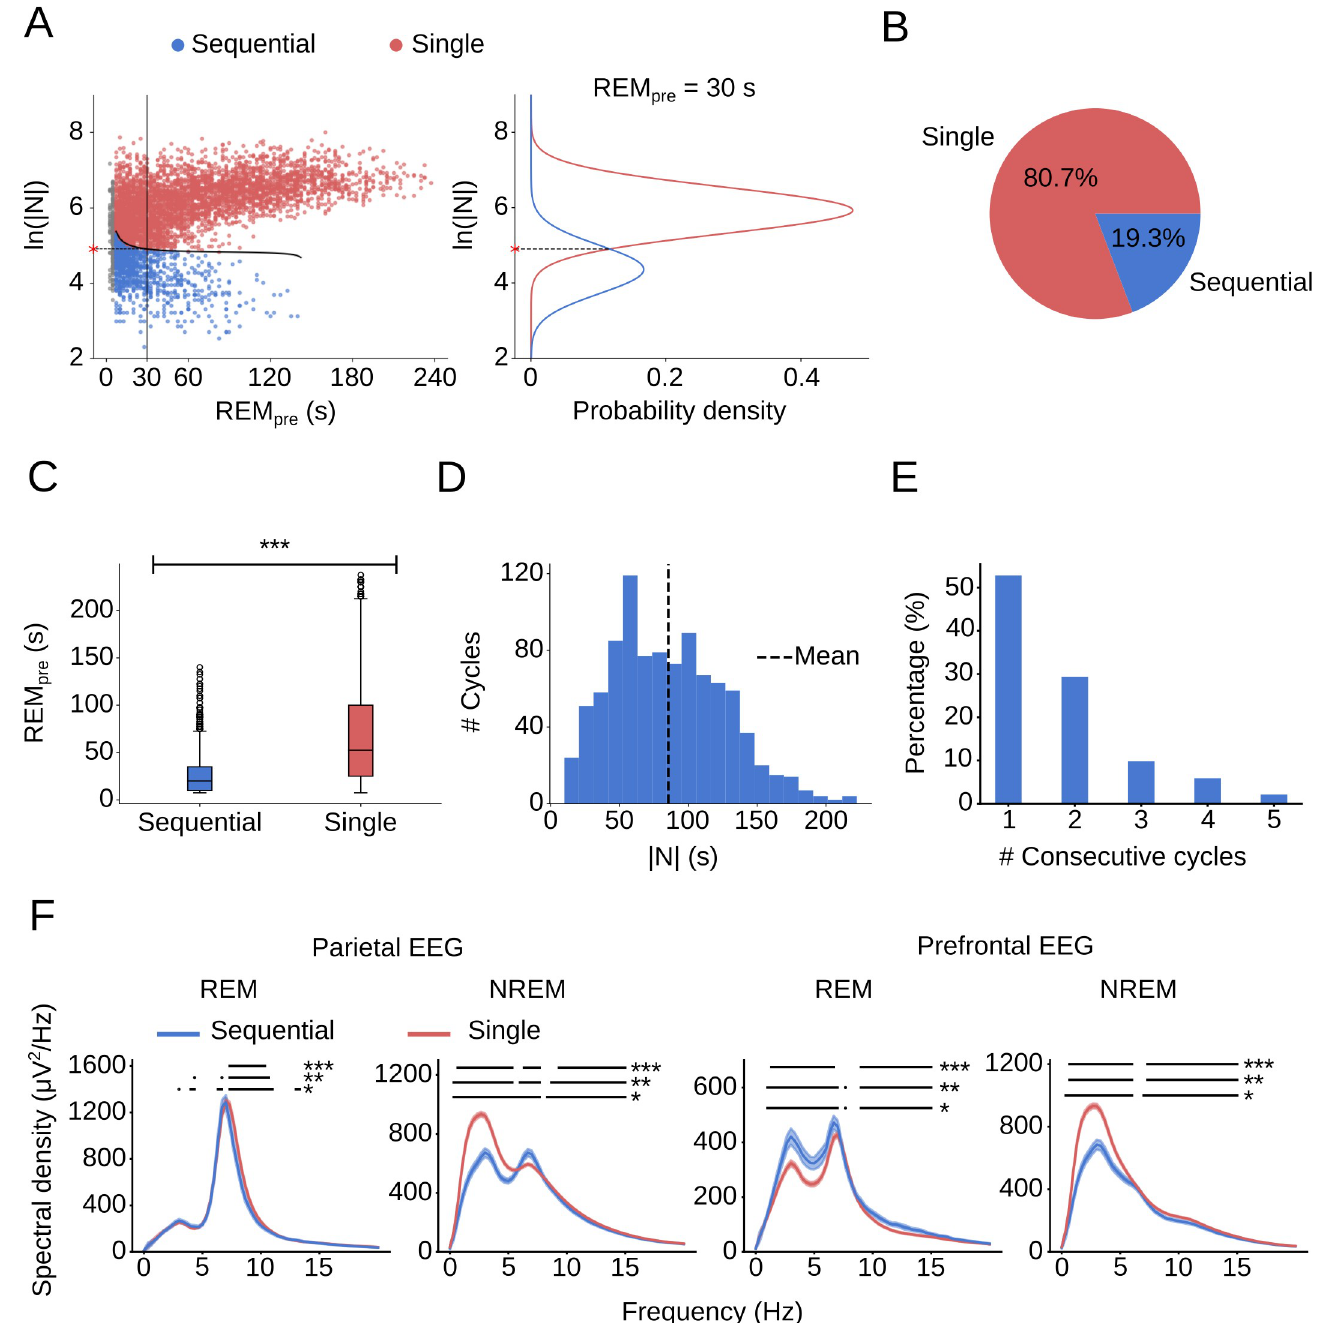
Fig 3. Sequential vs single cycles. (A) (Left) Scatter plot of REM pre vs. ln(|N|) with color-coded single and sequential cycles. The threshold optimally separating sequential from single cycles is shown in black. (Right) Illustration of how the threshold was determined for REM pre = 30 s. The probability density functions (PDFs) for the two distributions of the GMM (for REM pre = 30 s) are plotted along the y-axis. The red asterisk indicates the value of ln(|N|) at which the two Gaussians intersect. Values of ln(|N|) below the intersection point are more likely to be drawn from the short distribution and are consequently labeled as sequential cycles. Gray points correspond to cycles with REM pre < 7.5 s for which the conditional GMM is not defined ( S1B Fig and Methods ). (B) Pie chart indicating the percentage of single and sequential cycles. (C) Box plot comparing REM pre for single and sequential cycles. For sequential cycles, REM pre was shorter than for single cycles (Welch’s t-test, t = -35.13, p = 2.59e-228, n sequential = 947, n single = 3961). (D) Histogram of |N| for sequential cycles. The vertical dashed line indicates the mean (85.46 s ± 40.92 s; mean ± s.d.). (E) Bar plot showing the percentage of the number of cycles within a REM sleep sequence. Over half of REM sleep sequences contain only one cycle (i.e. comprise two REM periods). (F) Spectral density of parietal (n sequential = 947, n single , = 3961) and prefrontal (n sequential = 936, n single = 3919) EEG during REM and NREM sleep for both sequential and single cycles. Horizontal lines indicate frequencies at which the spectral density of